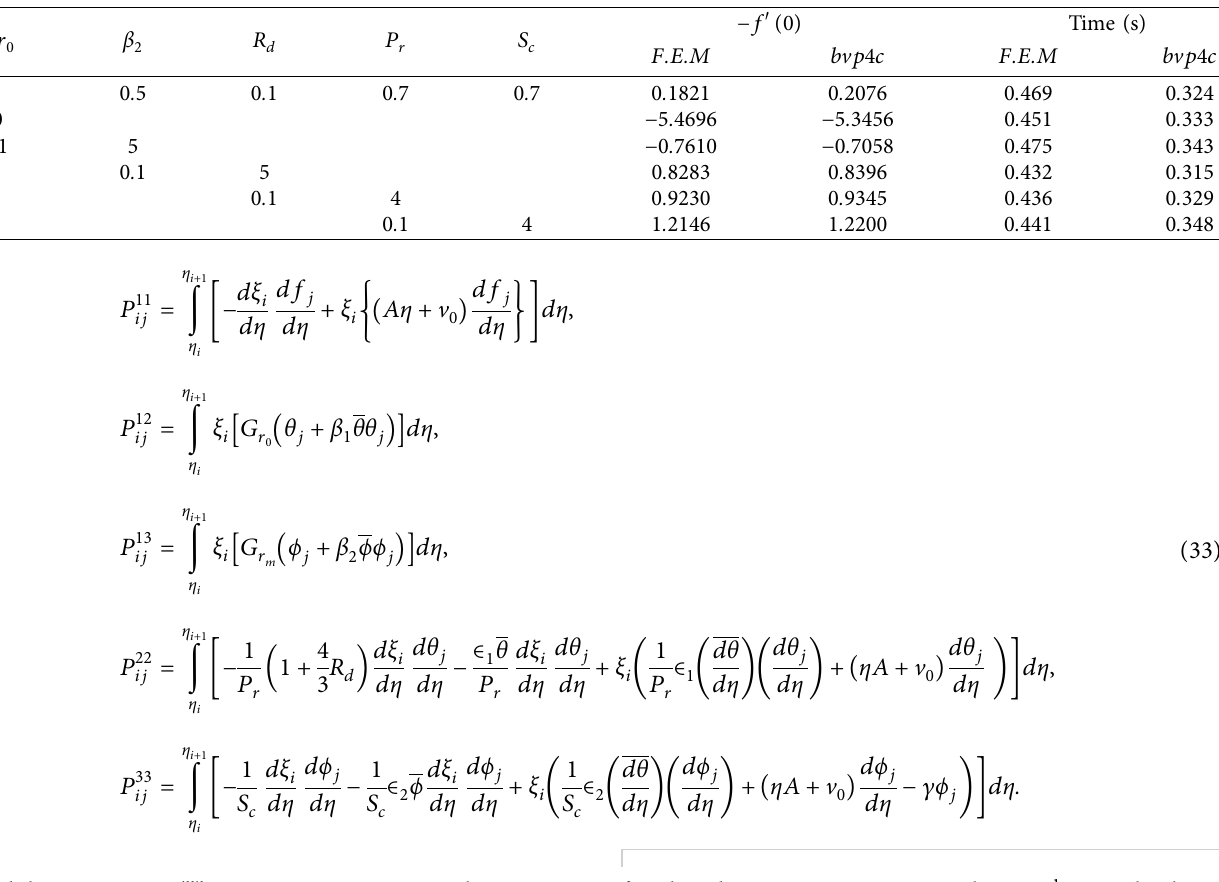
Table 1: Comparison of the finite element method and Matlab solver bvp 4 c in finding numerical values of − f ′ ( 0 ) using